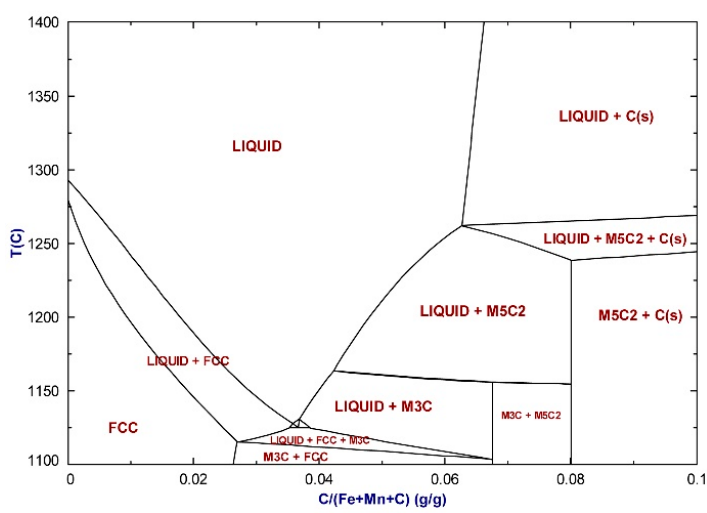
Figure 14. Mn-Fe-C phase diagram section at 50% Mn.